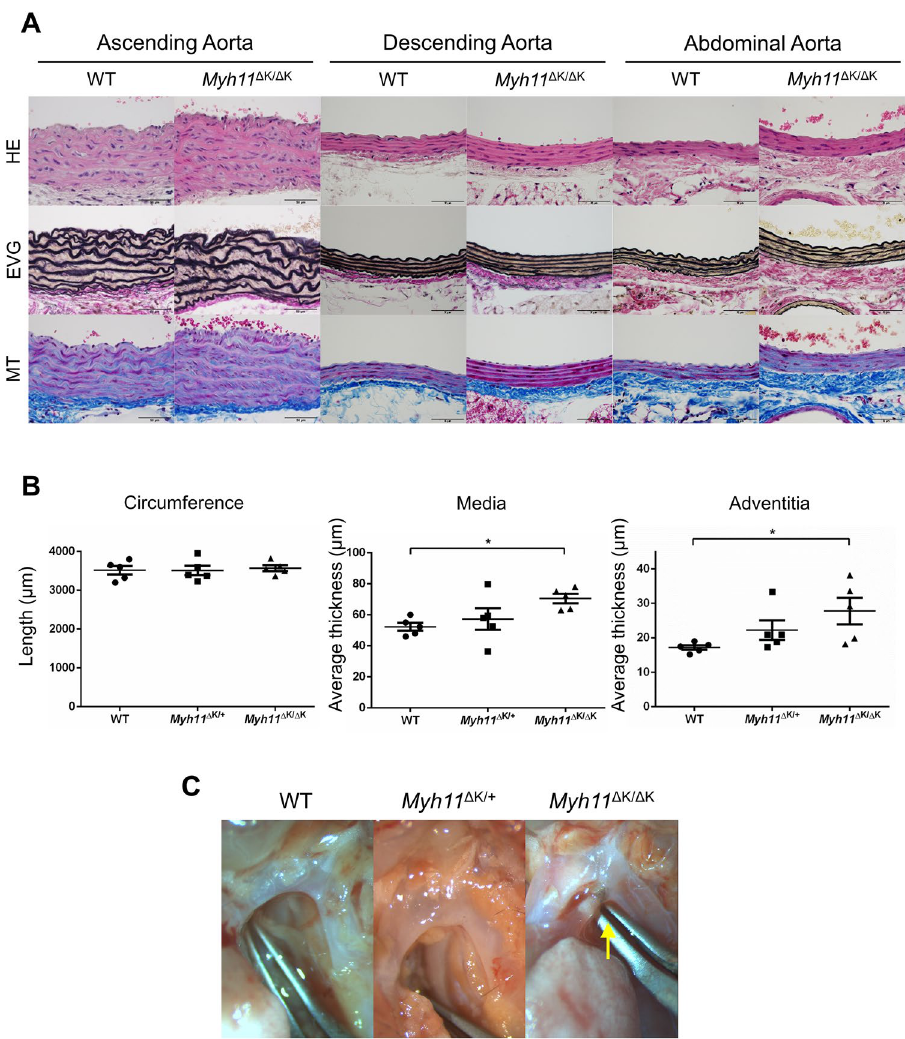
Figure 2. Myh11 ∆K/∆K ascending aortas showed phenotypes of medial degeneration. (A) Representative architecture of aortic wall (ascending, descending and abdominal aorta) from 12-week-old WT and Myh11 ∆K/∆K mice. Cross-sections were stained with haematoxylin and eosin (HE), Elastica van Gieson (EVG, for elastin) and Masson trichome (MT, for collagen; scale bars = 50 µm, × 400). Myh11 ∆K/∆K aortas showed partial tears of elastic fibres and an increased thickness of media and adventitia. (B) Morphometric parameters of WT, Myh11 ∆K/+ and Myh11 ∆K/∆K ascending thoracic aortas. Circumference length did not differ between the WT, Myh11 ∆K/+ and Myh11 ∆K/∆K aortas (left, n = 5), while the media thickness (middle, n = 5) and adventitia thickness (right, n = 5) of the Myh11 ∆K/∆K aortas were significantly increased compared to those of the WT aortas. ** p < 0.01, one-way ANOVA with Tukey post-hoc test. (C) Gross appearance of a shunt vessel between the distal arch and pulmonary artery, considered as patent ductus arteriosus (PDA), in 12-week-old Myh11 ∆K/∆K